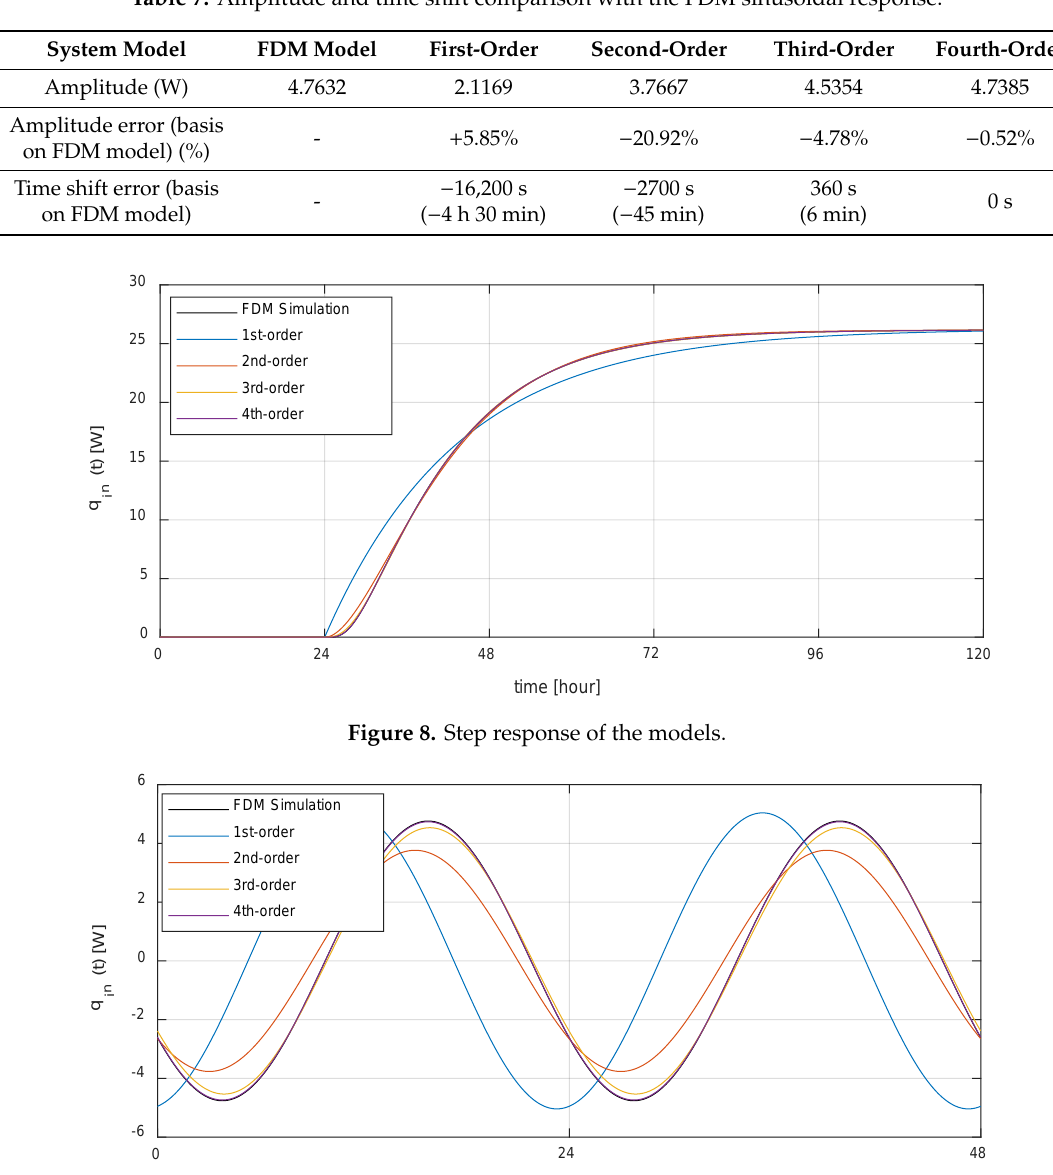
Figure 9. Sinusoidal response of the models.